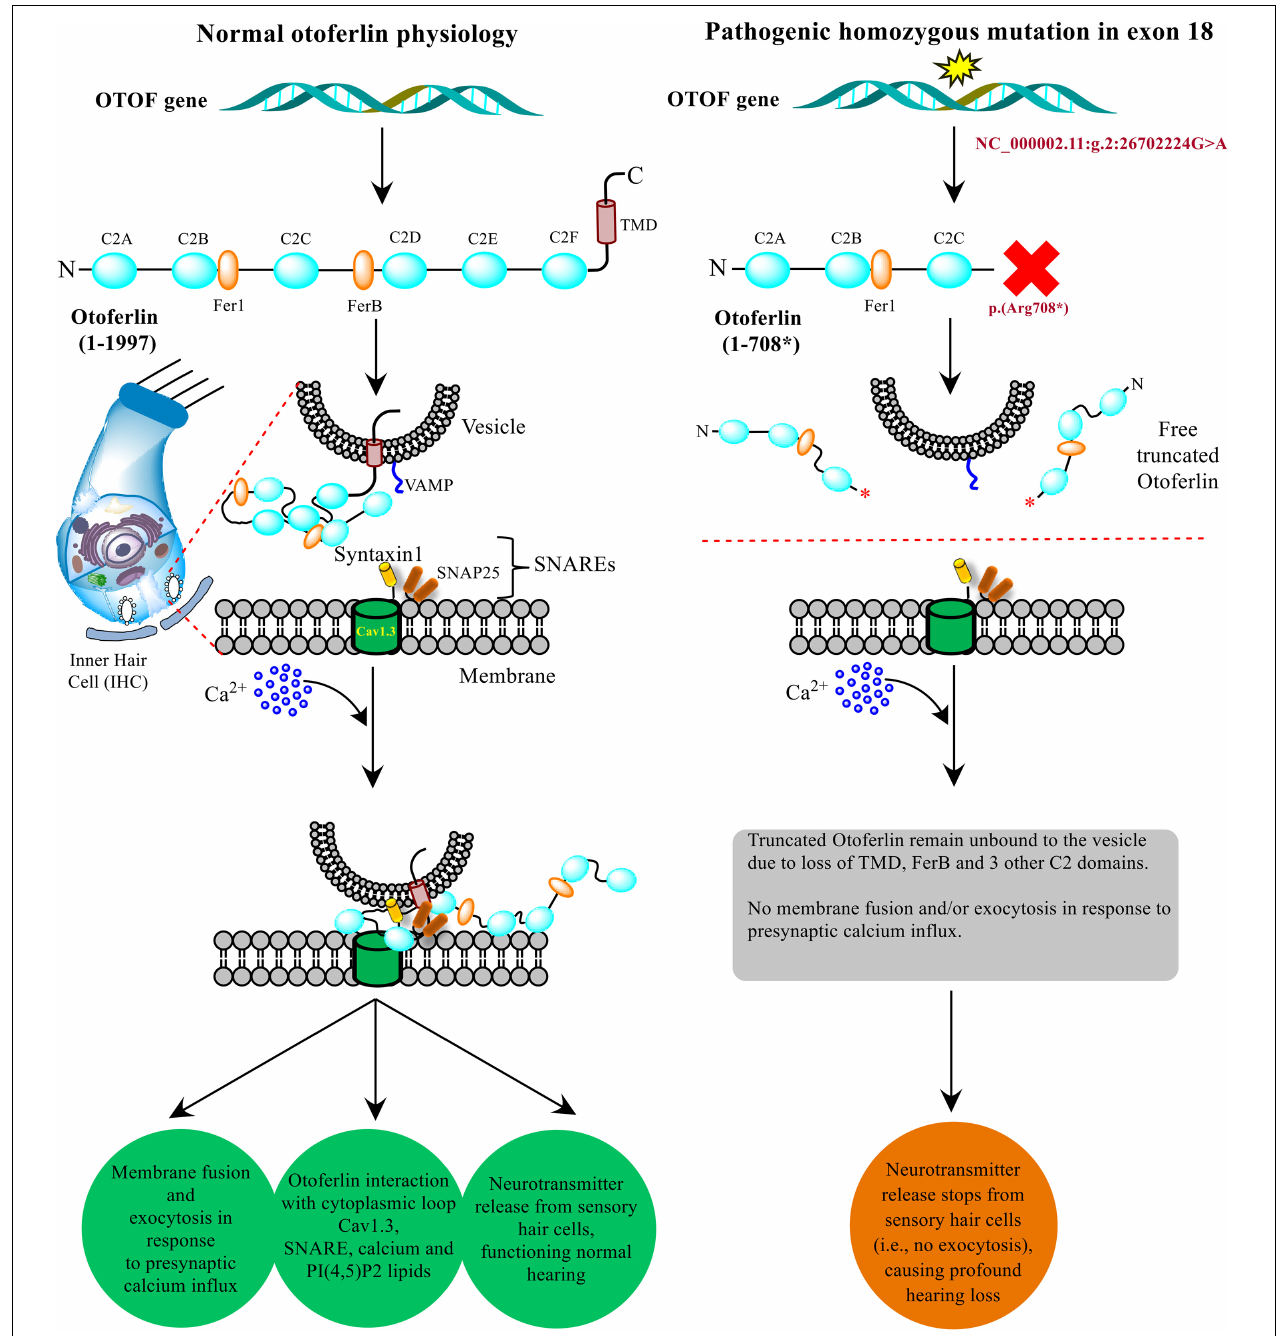
FIGURE 6 | Model presenting the role of OTOF in hearing physiology. The otoferlin expressed in the inner hair cells (IHCs) cochlea typically perform the neuronal synapse and exocytosis. A non-sense mutation brings stop codon (at p. 708*) in between C2C and C2D domains results in a truncated version of the protein, which disrupts the normal function and hearing physiology. The current model was adapted from the previously well-established experimental-based studies (Ramakrishnan et al., 2014; Shin, 2014; Chatterjee et al., 2015; Hams et al., 2017).